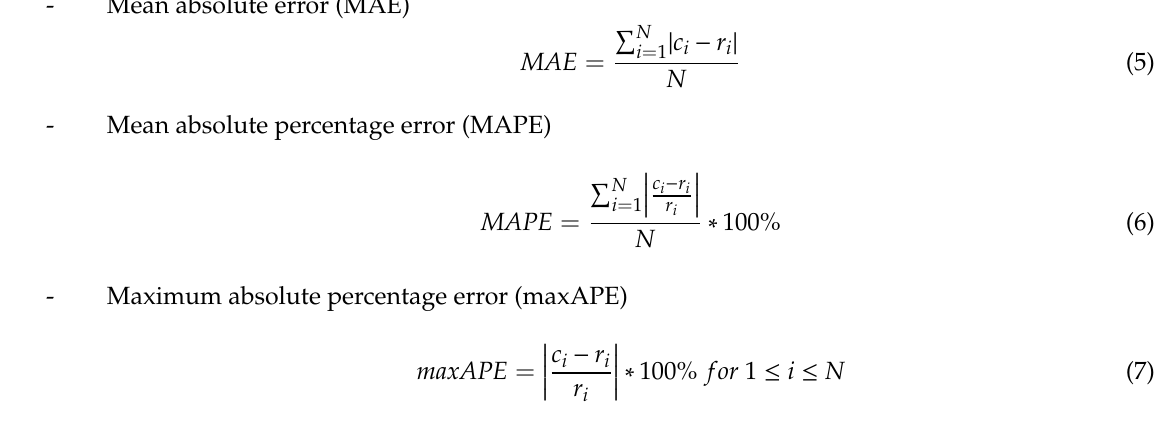
Table 5. The errors of predictions calculated.